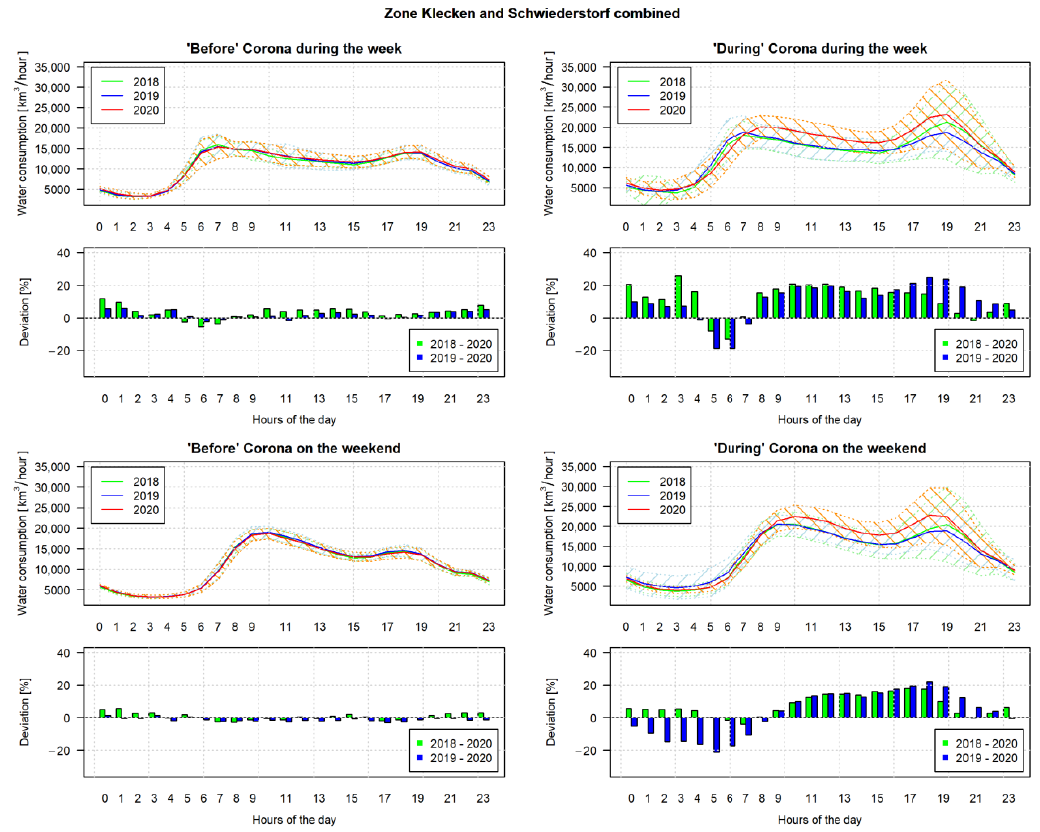
Figure 4. Hourly water consumption in two zones (Klecken, Schwiederstorf) for the first half of the three years (2018–2020) and the deviation from 2020 to the two previous years. Data were divided into time periods that corresponded to the days before and during strict Corona measures in 2020 and into weekdays and weekends. Solid lines show the mean consumption volumes per hour, dashed polygon lines show the standard deviation, and bars show the percentage deviation of volumes between 2020 and the two other years.